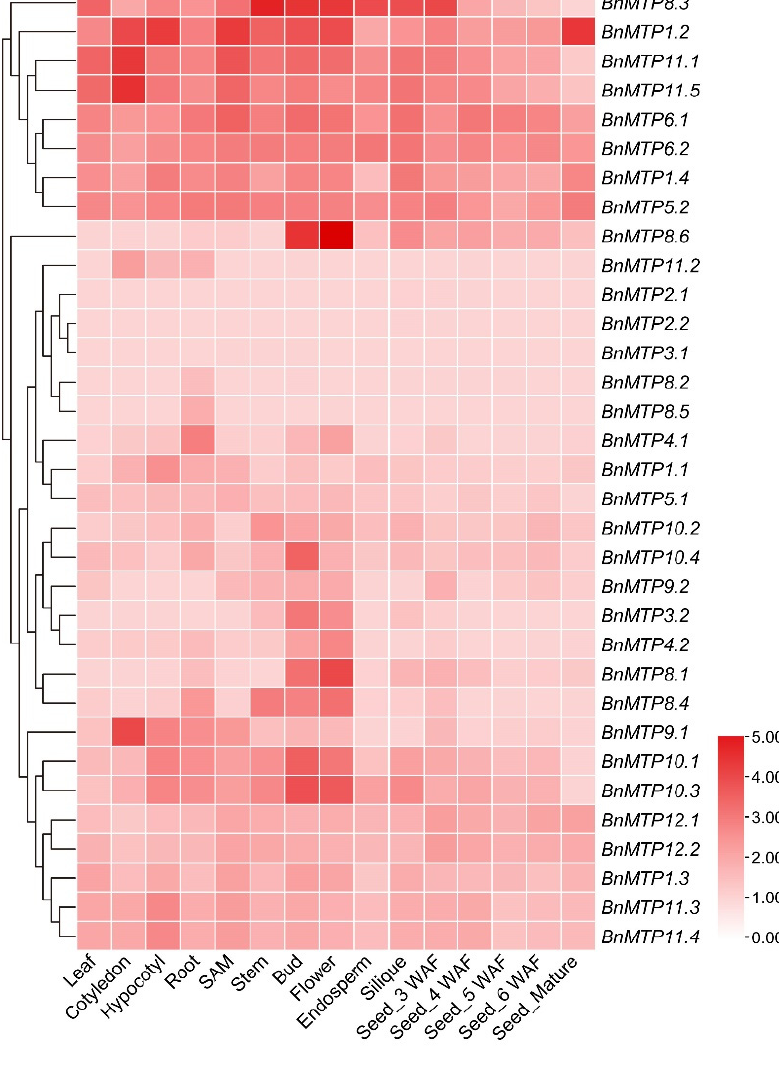
Figure 9. Temporospatial expression patterns of BnMTP genes. Normalized gene expression (FPKM + 1) is expressed in log 2 ratio.